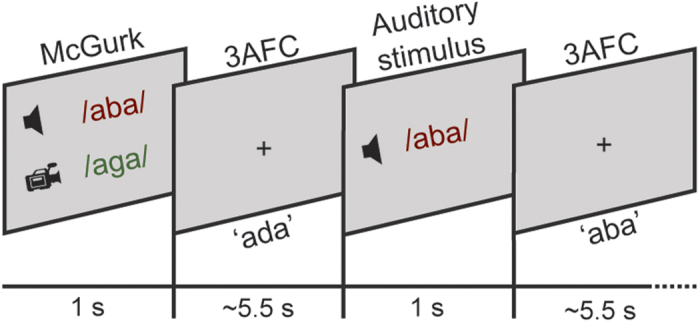
Experimental design.An audiovisual or auditory stimulus was presented on the screen for one second followed by a fixation cross period in which participants pressed a button to indicate whether they heard ‘aba’, ‘ada’ or ‘aga’ (three alternative forced choice; 3AFC). The next trial appeared after 4.5 to 6.5 seconds.